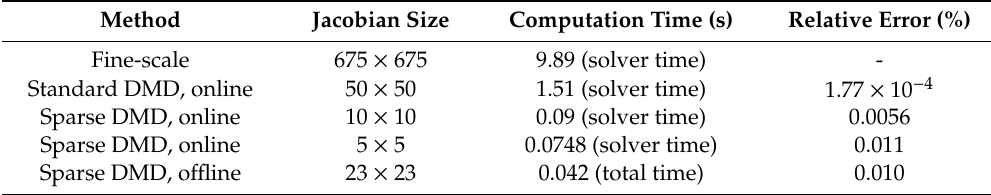
Table 1. Computation time of solver with di ff erent model order reduction (MOR) method.